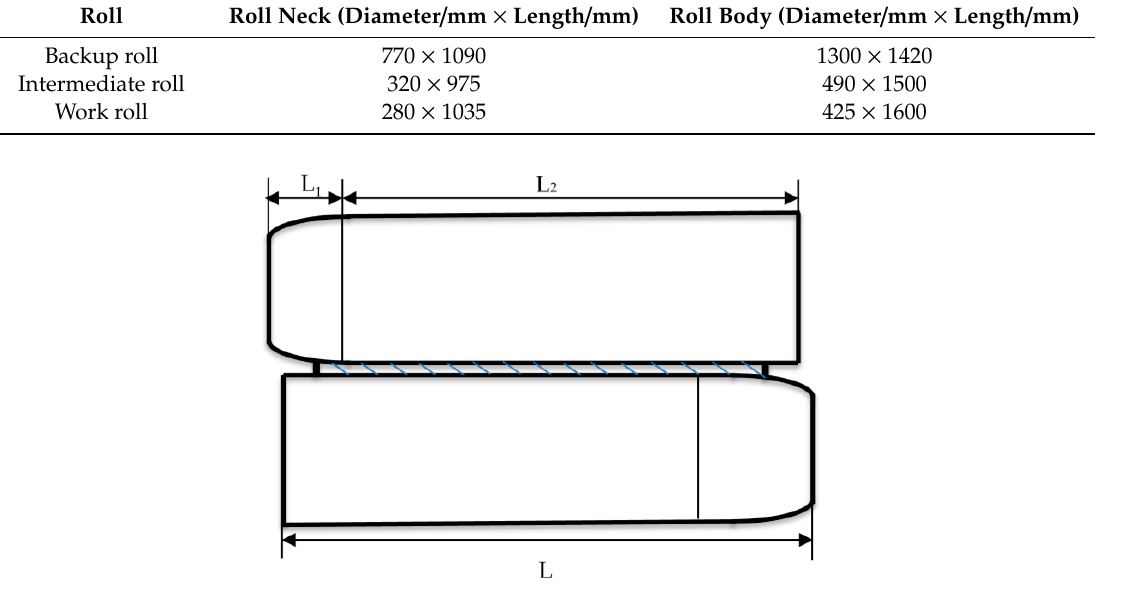
Figure 2. Roll shape structure of single-sided taper work roll. Table 2. The initial end roll shape